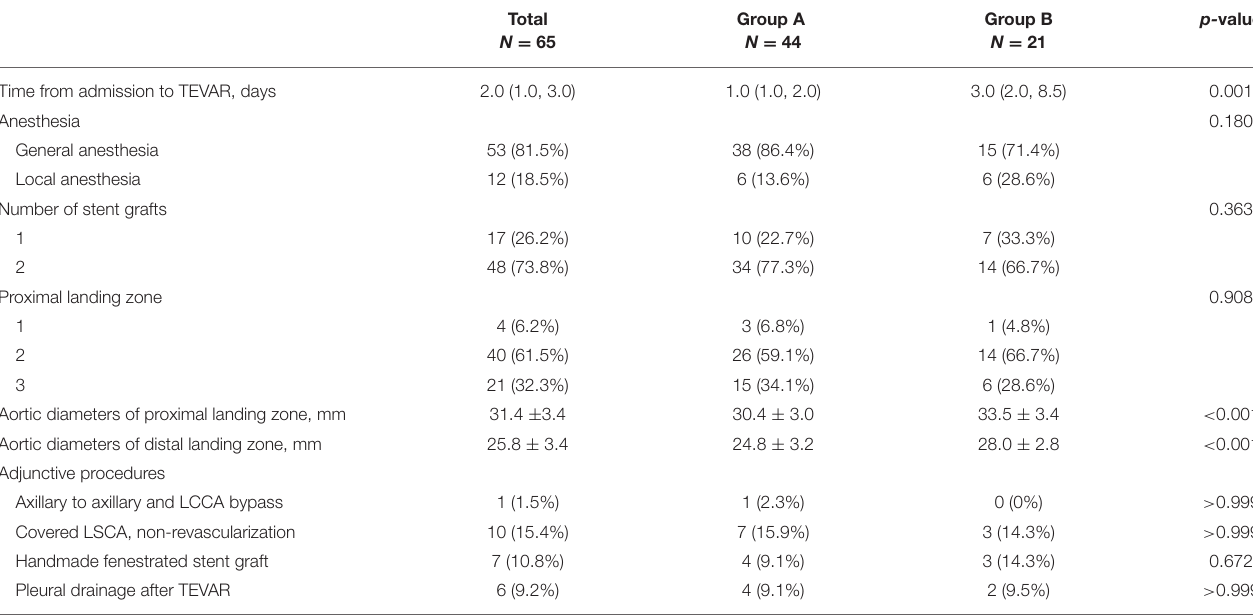
TABLE 3 | Intervention details in patients with entry tear (Group A) and penetrating atherosclerotic ulcer (Group